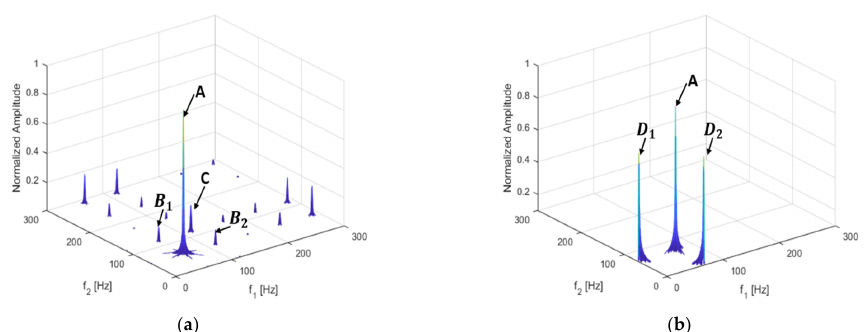
Figure 4. Bispectrum of the cantilever structure ( a ) when p = 50%, q = 30%; ( b ) when there is no damage.